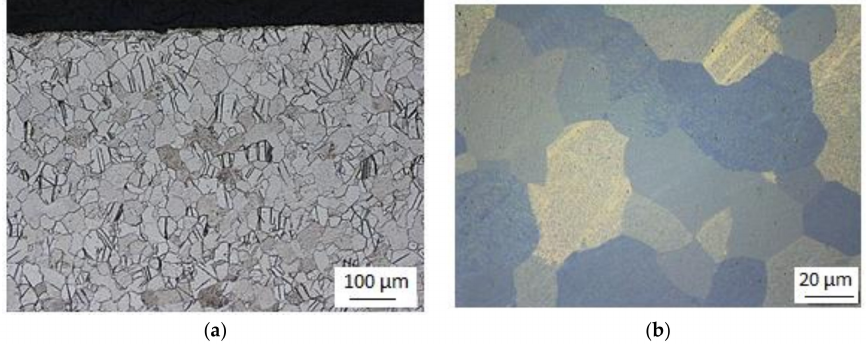
Figure 3. ( a ) Micrograph of the as-received structure in the transverse direction; ( b ) detailed micrograph of the as-received